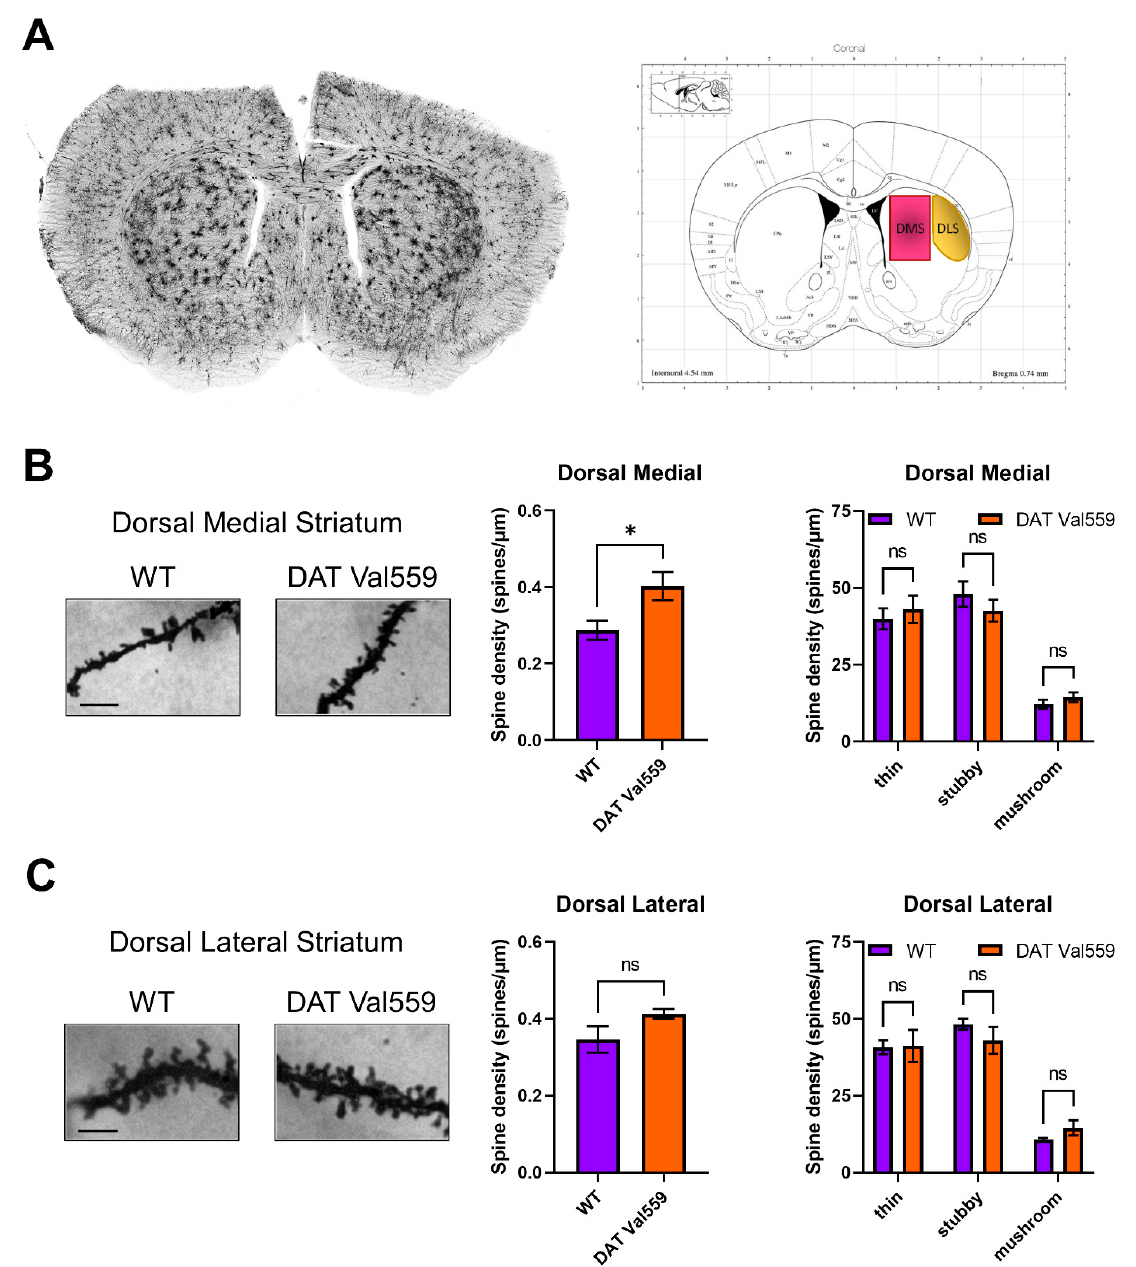
Figure 5. Dendritic spine density is increased in the DMS of male DAT Val559 mice. Spine density in sections from WT ( n = 4) and DAT Val559 ( n = 4) mice was assessed utilizing Golgi staining coupled to brightfield microscopy. ( A ) Representative whole coronal slice and notation of regions analyzed. Representative images [scale bar = 100 µ m], total spine density, and spine densities for each distinct morphology (thin, stubby, and mushroom) are provided for both the ( B ) DMS and ( C ) DLS. Data were analyzed by two-tailed Student’s t -test or two-way ANOVA with Sidak’s multiple comparison’s test. * p < 0.05. ns = not significant. Data are presented as mean ±